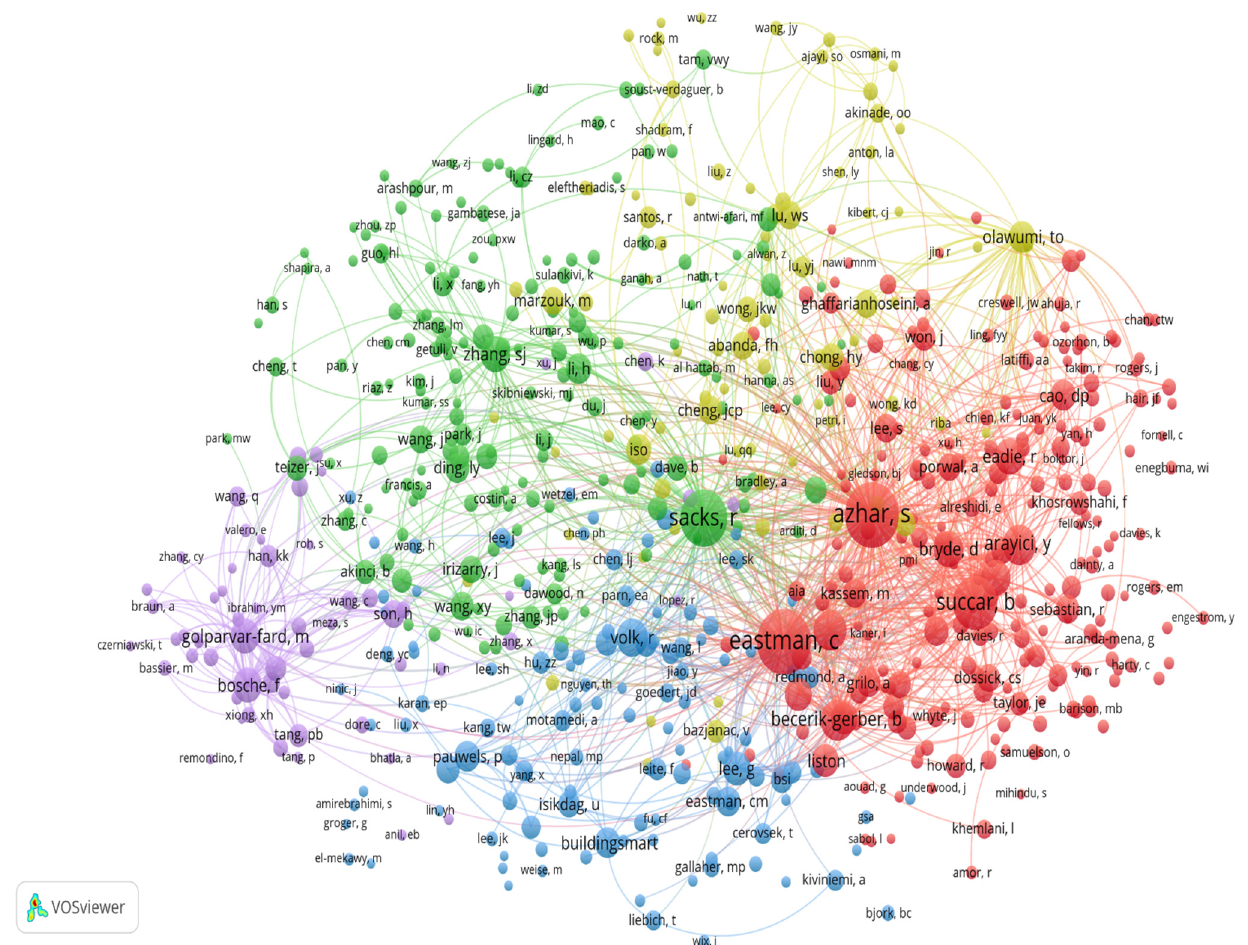
Figure 6. Author co-citations network.